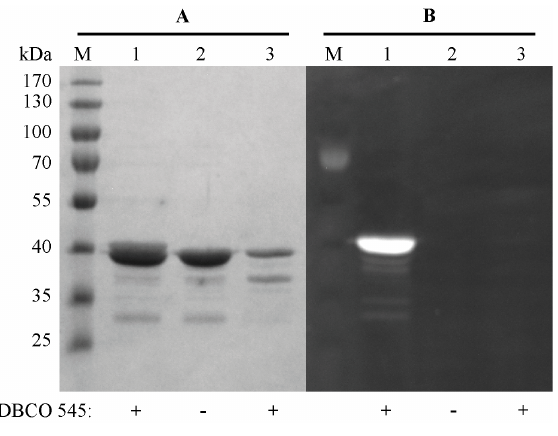
Figure 5. SDS-PAGE analysis of the SPAAC click reaction between CK2 α -pAzF and the fluorophore DBCO545. Protein solutions were separated on 10% acrylamide. In lane M, the apparent molecular mass of the marker proteins is given. Purified and concentrated CK2 α -pAzF (11 µg) in presence and absence of DBCO545 in a final concentration of 50 µM are shown in lane 2 and lane 1, respectively. As control purified full length CK2 α (2.8 µg) without incorporated pAzF was also incubated with DBCO545 (lane 3). ( A ) Proteins were stained with Coomassie brilliant blue G250. ( B ) Visualization of the fluorescent protein band of CK2 α -DBCO545 by LED-illuminator (470 nM).